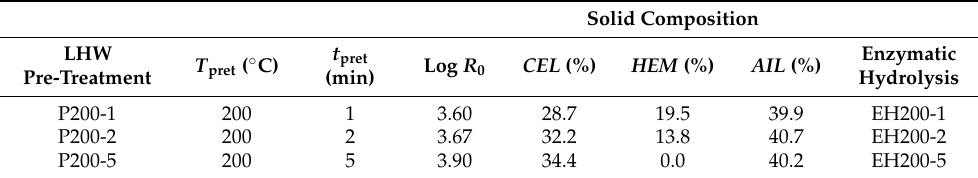
Table 4. Effect of LHW pre-treatment time ( t pret ) on pre-treated solids.